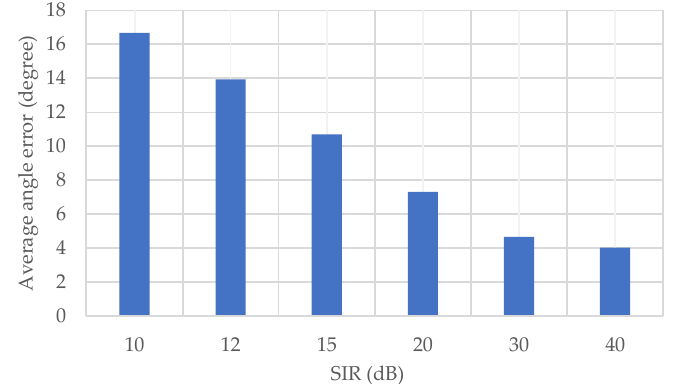
Figure 12. Average angle error for each SIR (signal-to-interference ratio).